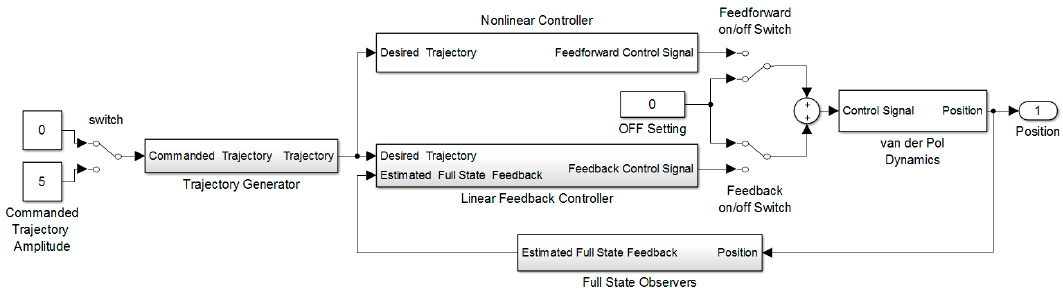
Figure 1 . Overall control topology coded in MATLAB/SIMULINK software. Figure 1. Overall control topology coded in MATLAB/SIMULINK